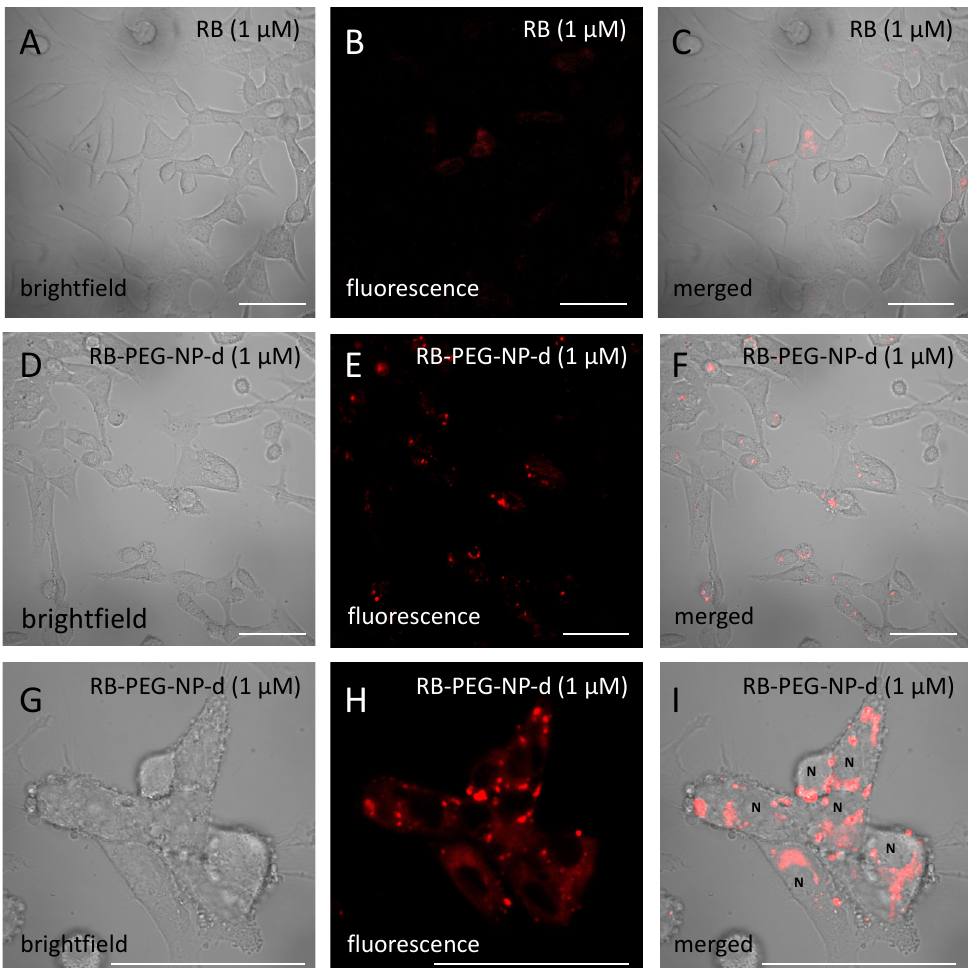
Figure 4. Cell viability (MTT assay) of HeLa cells exposed to different RB concentrations, ( A ) in solution, and ( B ) tethered at MNS (sample RB-PEG-NP- d ) under dark conditions (blue bars) and green irradiation at 518 nm and 10 J/cm 2 (orange bars). Stars indicate significant differences with respect to controls. Asterisks indicate significant differences between dark and light conditions at the same concentrations tested.